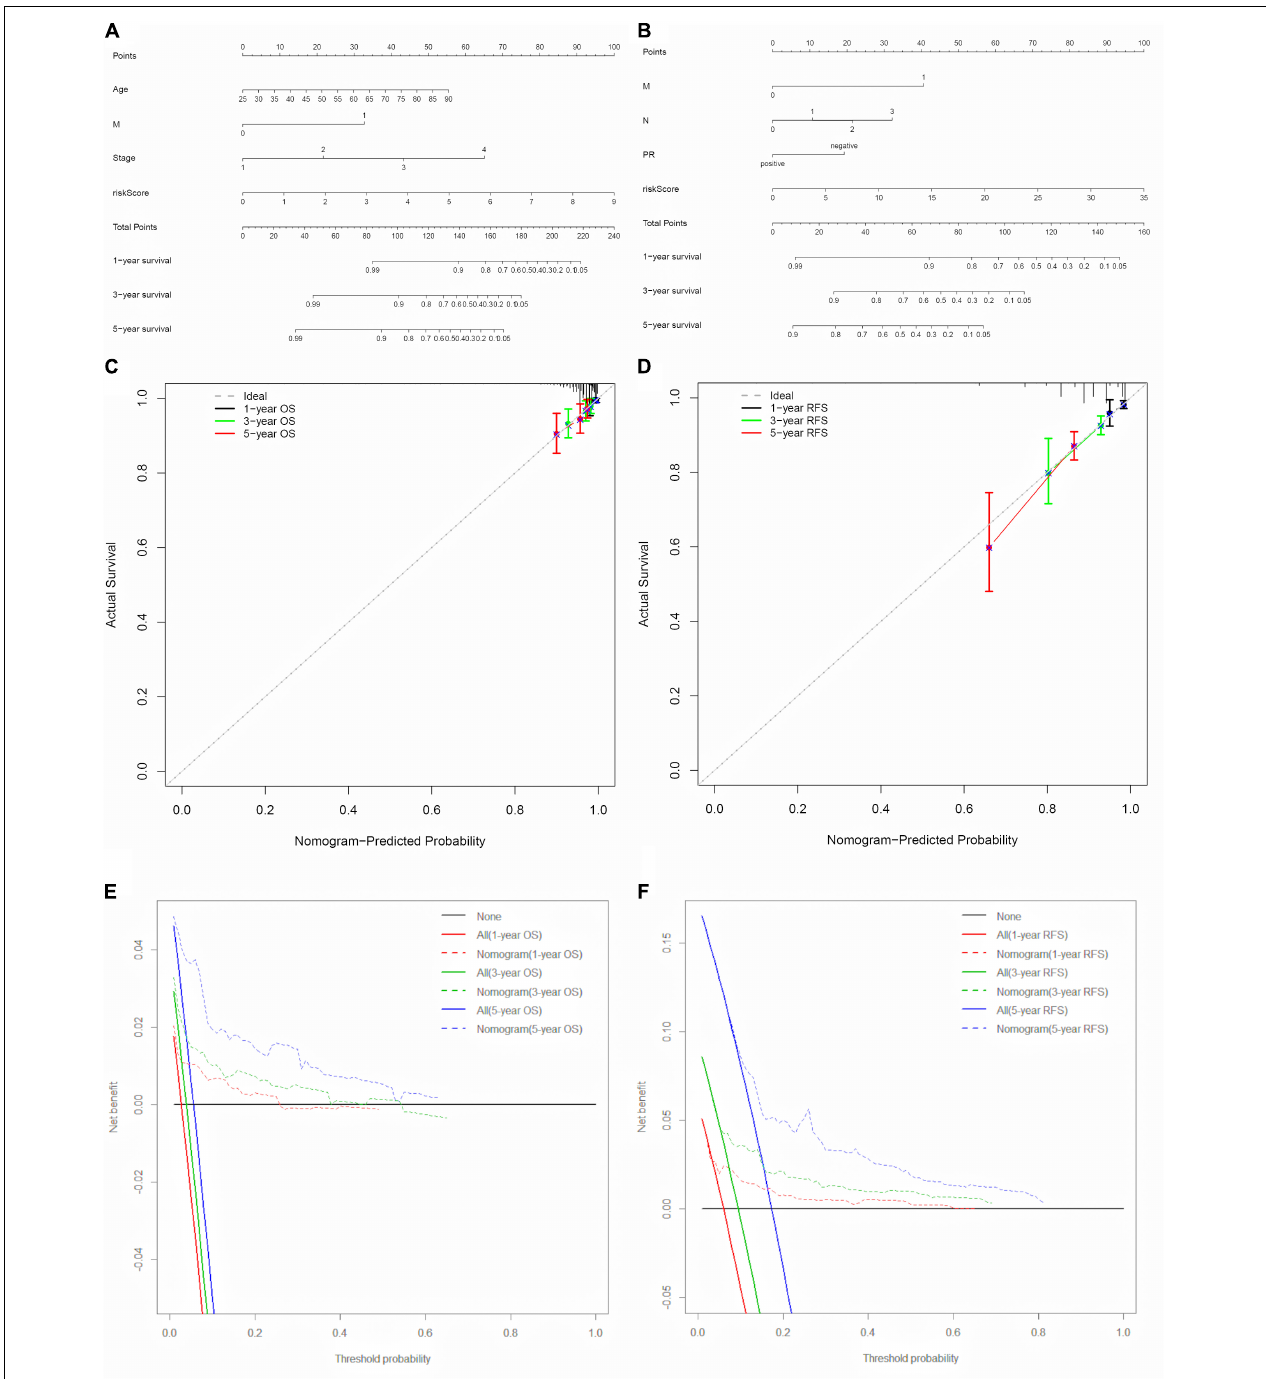
FIGURE 8 | Nomogram models for the prediction of BC prognosis in the whole set. (A,B) Nomograms for predicting probability of OS and PFS at 1, 3, and 5 years. (C,D) Calibration curves of the nomograms at 1, 3, and 5 years for OS and RFS. (E,F) Decision curves of the nomogram at 1, 3, and 5 years for OS and RFS.